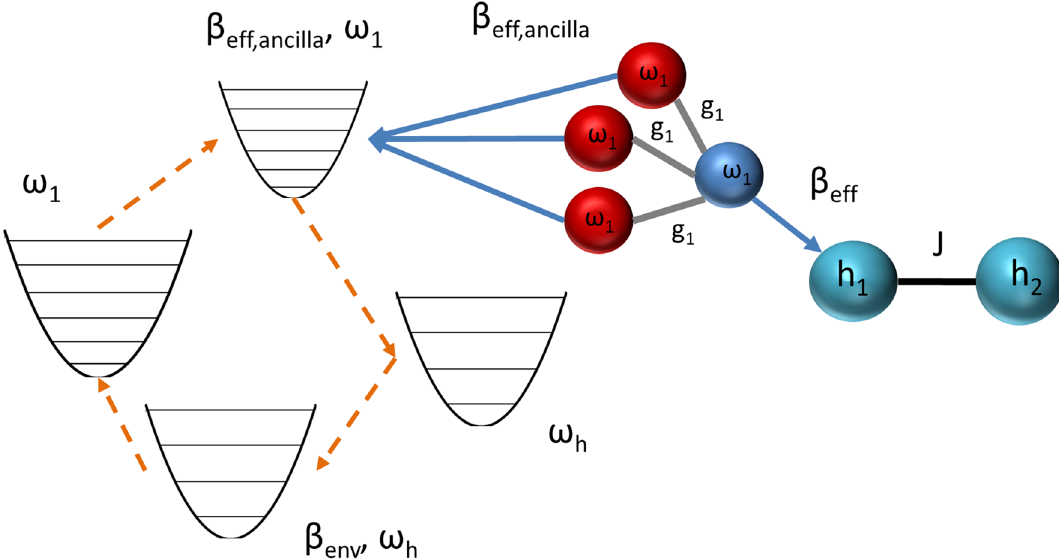
Figure 8. Simplified sketch of an improved quantum many-body refrigerator which uses the cold ancilla qubits in a quantum Otto cycle to mimic a cold reservoir and harvest work from the environment, which is the hot reservoir of the cycle. The central qubit is used to cool down the system C along with other refrigerant qubits from other spin-star systems (omitted in the figure for simplicity) with its effective temperature β eff from Eq. (4) while the ancilla qubits at effective temperature β eff,ancilla from Eq. (23) are used to mimic a cold reservoir for a quantum Otto cycle in which the working medium is a separate quantum harmonic oscillator as shown on the left side of the figure. The spheres in light blue and the sphere in dark blue represent the system C and the system B respectively while the spheres in red are the ancilla qubits of the system A. The arrows in blue represent the collisions which cool down the target system pointed by the arrow. The dashed arrows in orange represent the evolution of a single harmonic oscillator throughout its Otto